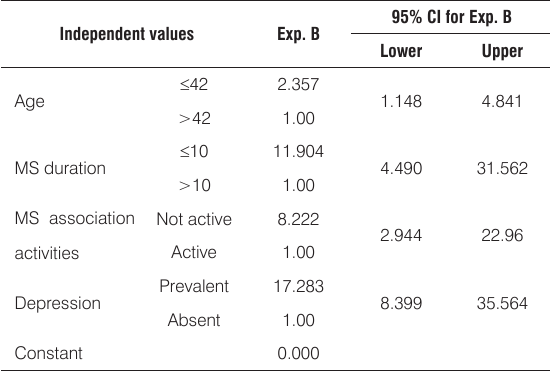
Table 4. Relation between anxiety and socio-demographic and clinical factors.